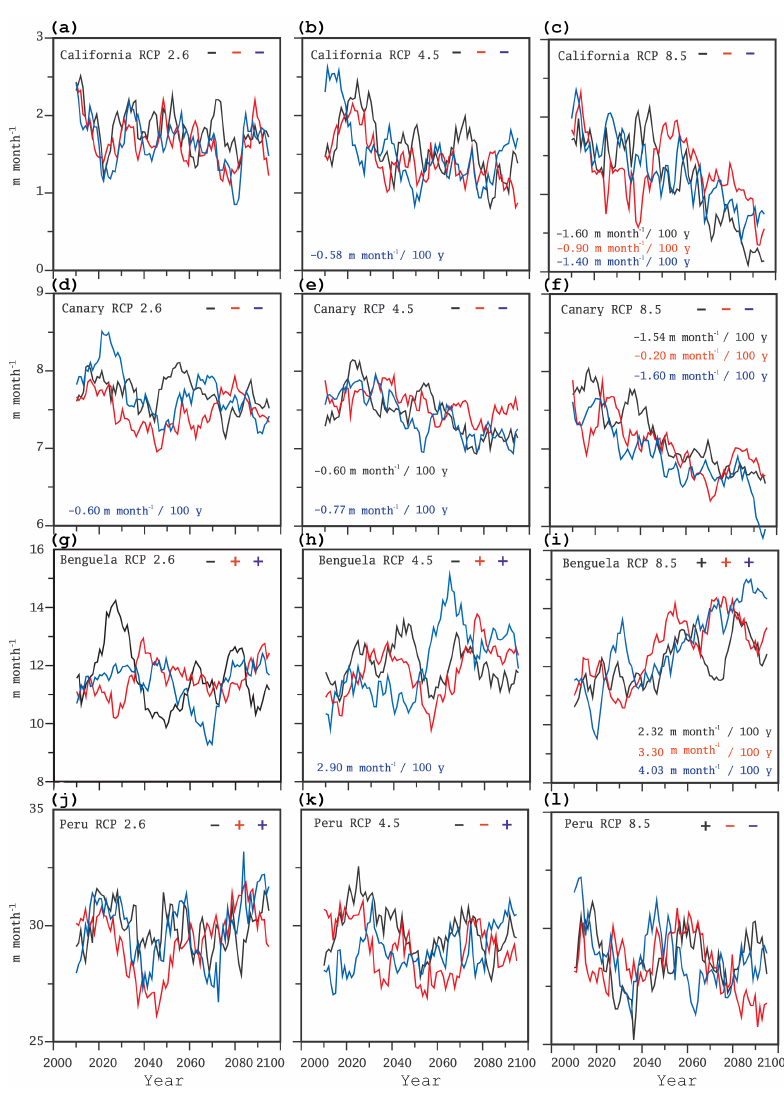
Figure 10. Time series of the simulated upwelling indices in each upwelling region simulated in three ensembles of climate simulations (three members each) for 2006–2100, rcp2.6, rcp4.5, and rcp8.5, with the MPI-ESM model. The plus and minus signs in each panel indicate the sign of the long-term trend, their value being included whenever statistically significant. The series have been low-pass filtered with a 10-year